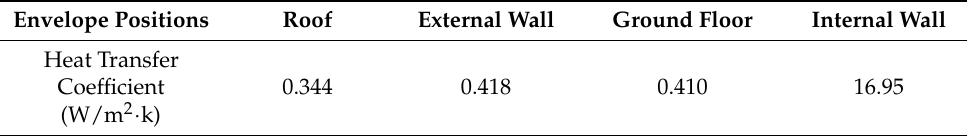
Table 2. Heat transfer coefficients of the container housing